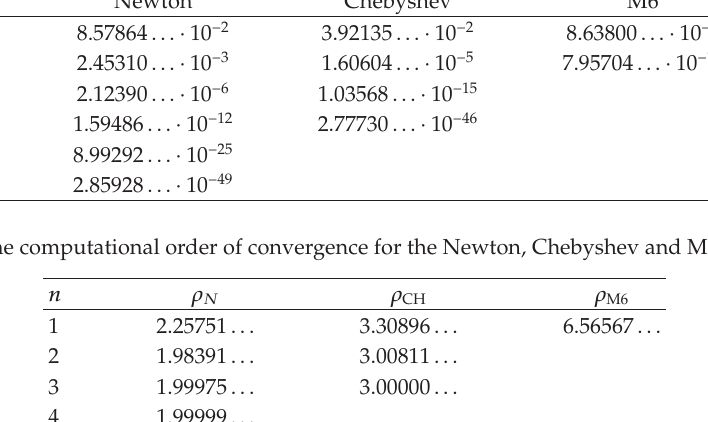
Table 1: Errors for the Newton, Chebyshev and M6 methods. n